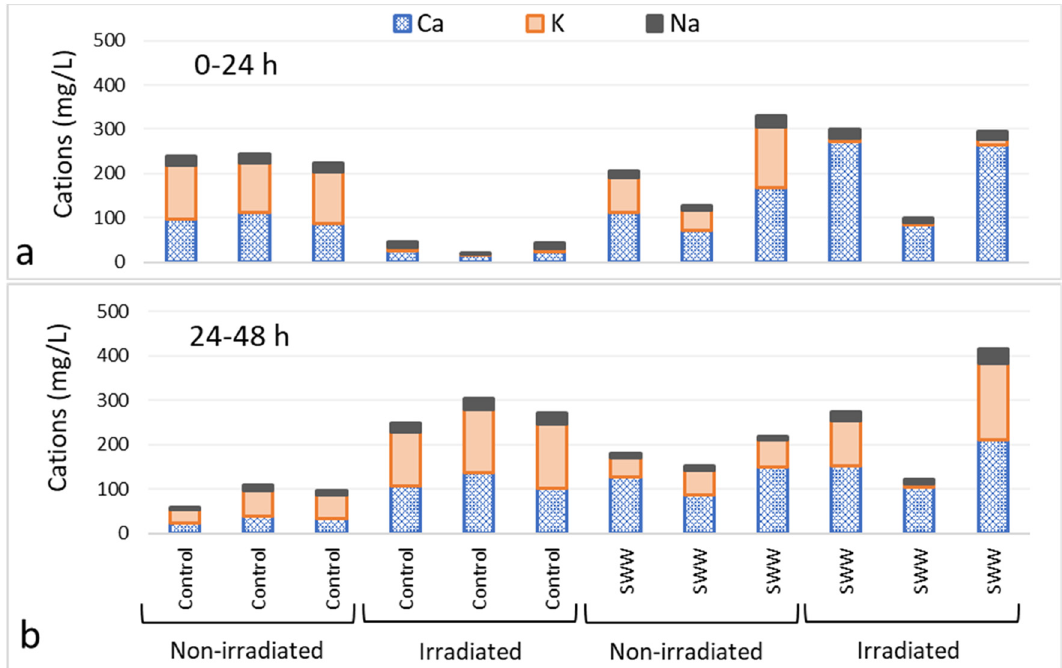
Figure 5. Major cations measured in the eluant from each column replicate for the first ( a ) and second ( b ) day of the experiment. Figure ( a ) is vertically aligned with ( b ).